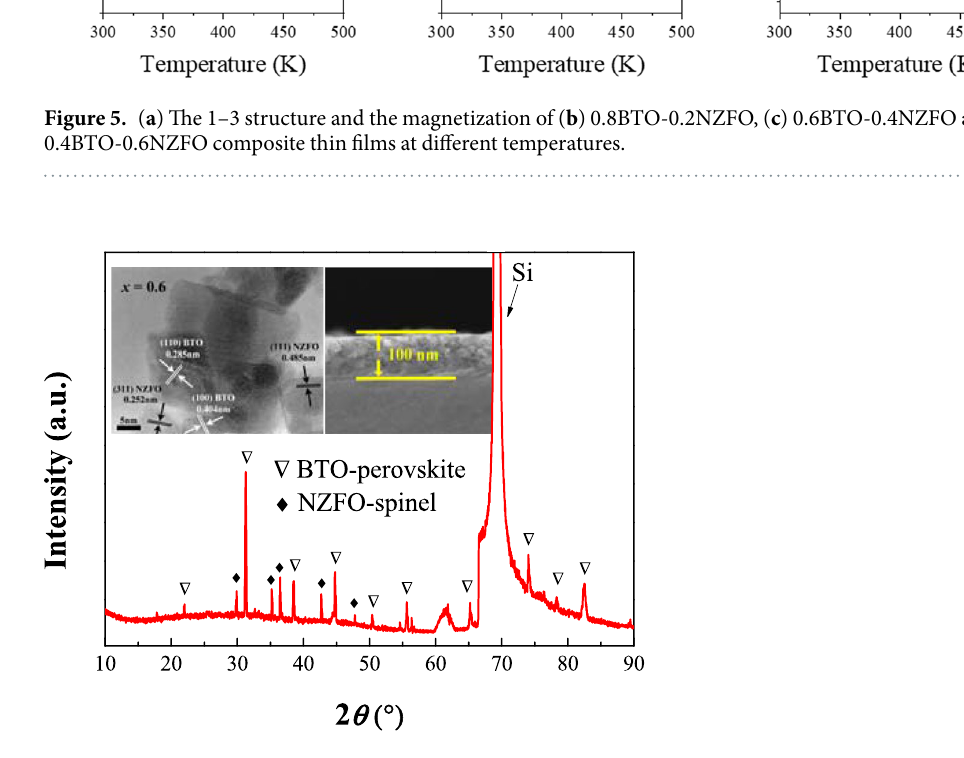
Figure 6. XRD pattern, TEM and cross-sectional SEM images of 0.4BTO-0.6NZFO composite thin